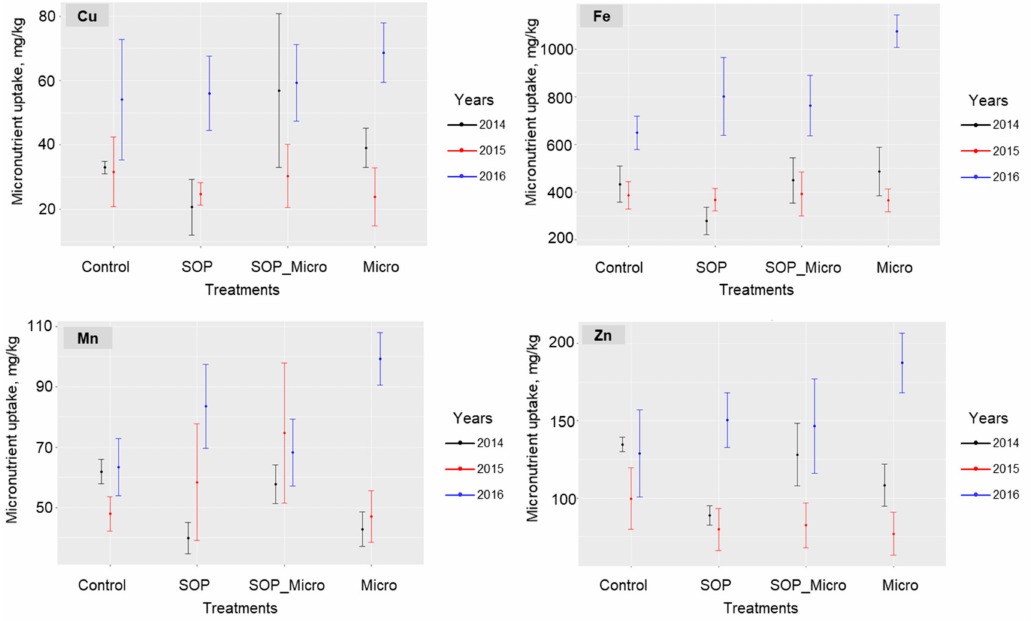
Figure 5. E ff ect of foliar fertilization with potassium and micronutrients on micronutrient uptake in the variety Zorba at the stage in full maturity.